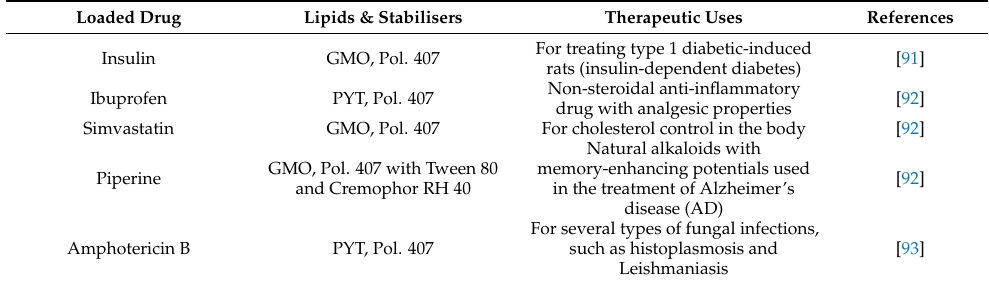
Table 10. Oral drug delivery utilising cubosomes formulation.